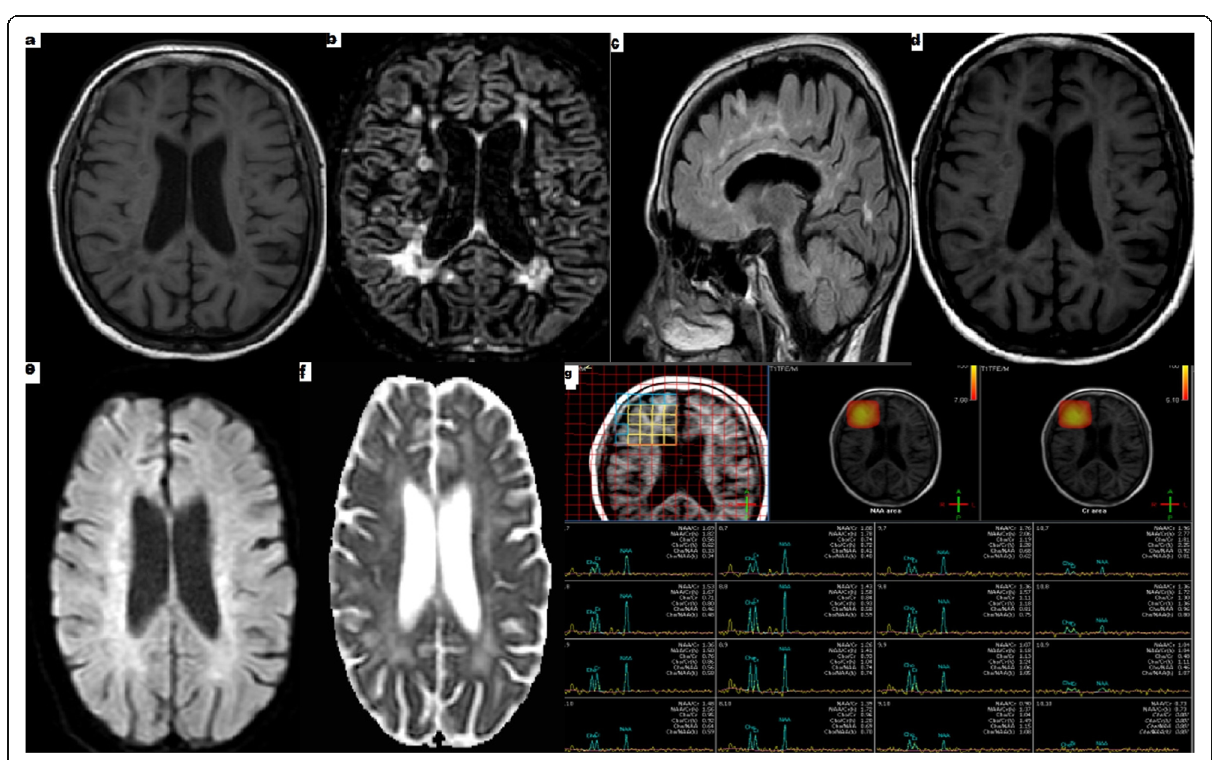
Fig. 2 “ A 33-year-old female patient ” MRI exam revealed multiple well-defined abnormal signal intensity foci scattered at the white matter of both cerebral hemispheres and posterior fossa that exhibit iso-hypointense signal at T1 ( a ) and hyperintense at 3D Gr and FLAIR ( b , c ) with no associated edema. DWI and ADC map ( d , e ) showed mixed diffusion changes (restriction/T2 shin effect). Post Gad ( f ) showed no contrast enhancement. MRS ( g ) revealed no significant metabolic changes with maintained ratios at the lesional and pre-lesional areas. MRI diagnosis: multiple sclerosis. Clinical diagnosis and follow-up: